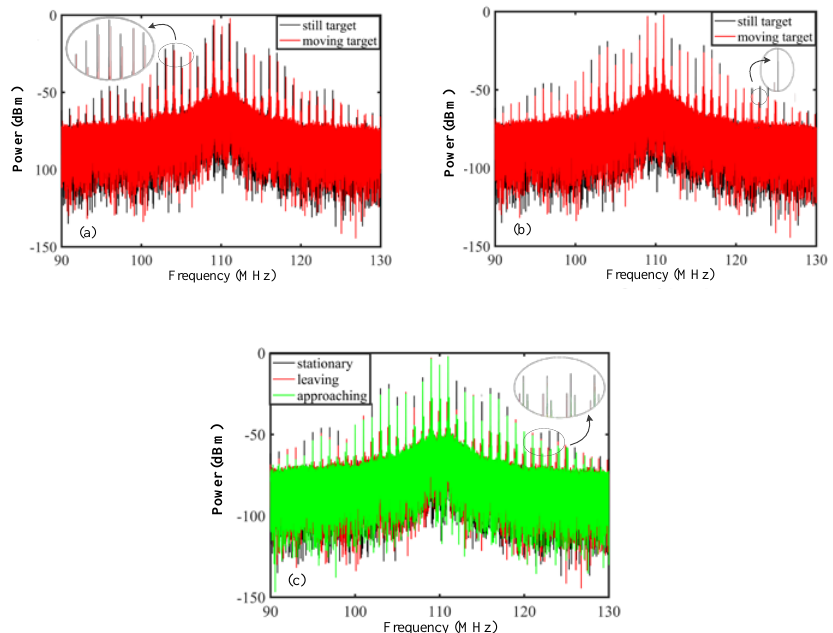
Figure 3. Beat notes when the target is moving and stationary. The black line is the spectrum when the target is stationary; the red line is the spectrum when the target is moving away from the collimator. ( a ) Fourier transforming the waveform obtained by the oscilloscope; ( b ) translating the red comb and moving its center frequency to 110 MHz; ( c ) frequency spectrum of the target in different states.